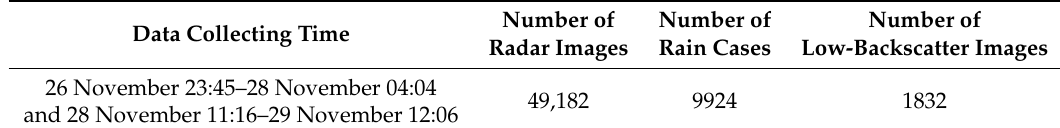
Table 1. Data Information.